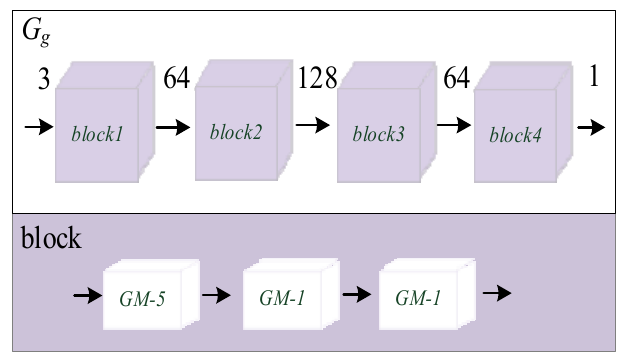
Figure 4. The proposed network of G g.